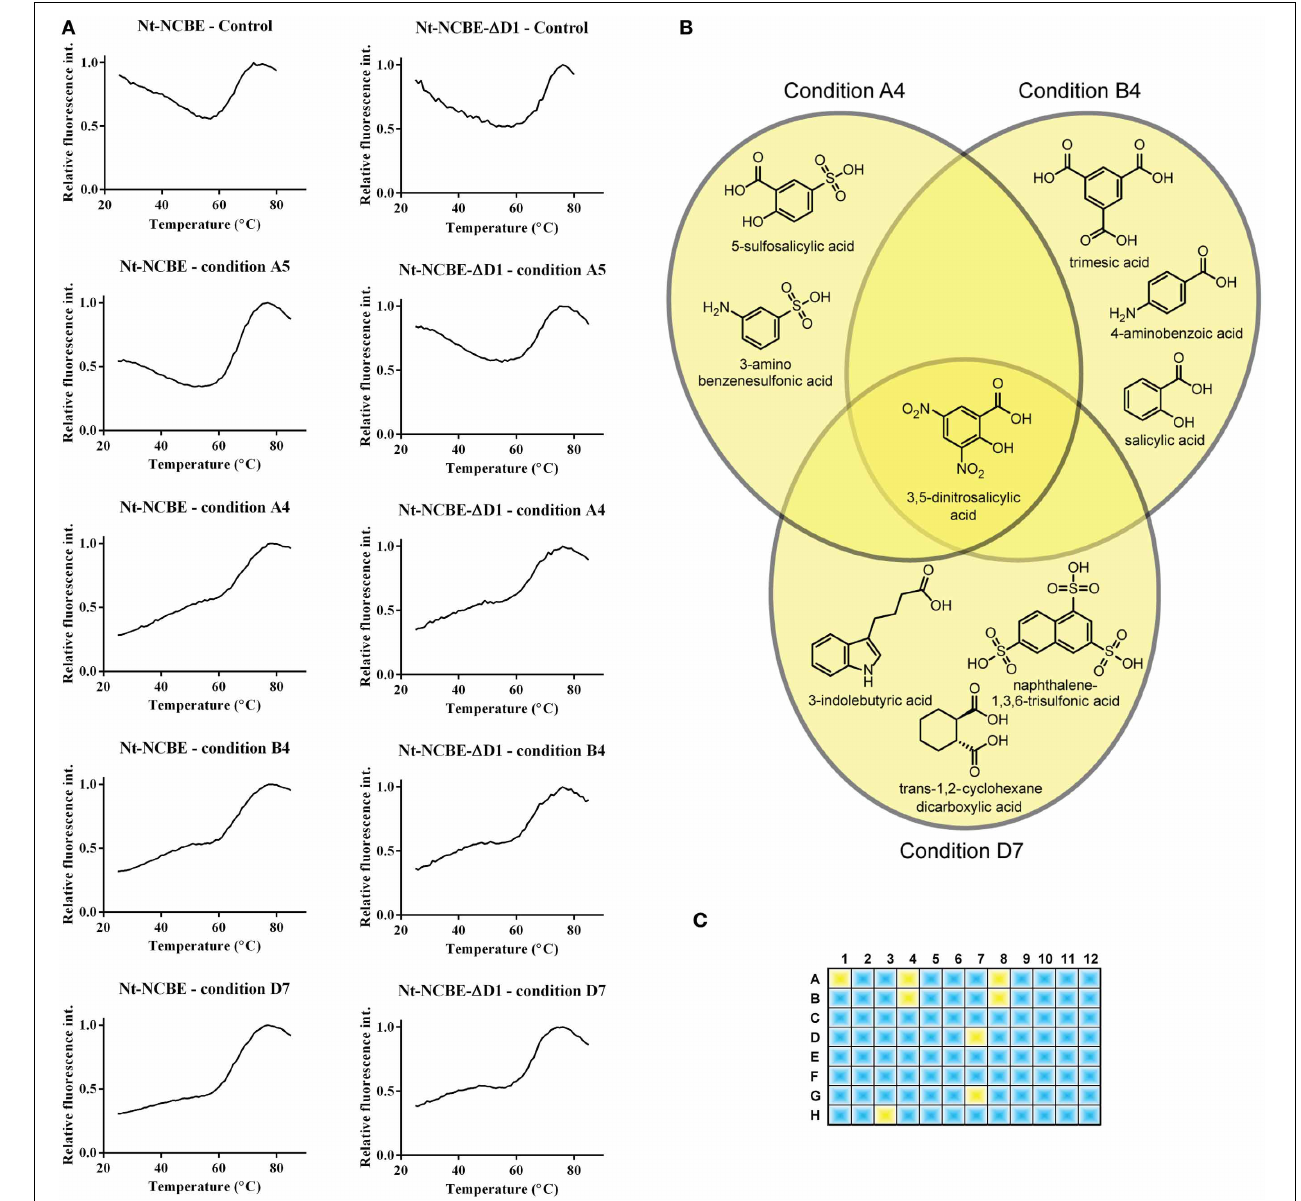
FIGURE 4 | Screening for interacting small molecules using the thermofluor assay. (A) Control thermofluor spectra for each construct in the absence of screen molecule showed high initial fluorescence commonly associated with non-folded proteins (Phillips and de la Pena, 2011). Thermofluor spectra of conditions A4, A5, B4, and D7 for both Nt-NCBE and Nt-NCBE- (cid:2) D1 using the Silver Bullets screen: two general profiles were observed. Condition A5 is representative of a “no interaction” profile similar to the control. Conditions A4, B4, and D7 are profiles showing low initial fluorescence and a multi-state melting profile indicating interaction between the construct and the small molecule. We interpret these as weakly stabilized structures. The general hit profiles were found for both Nt-NCBE and